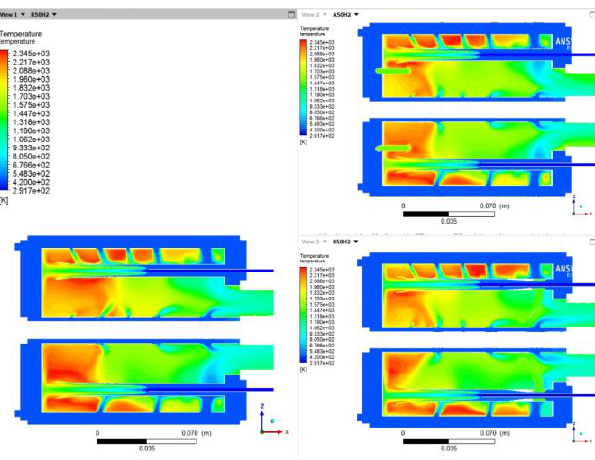
Fig. 10. Combustion static temperature field for 50% hydrogen mass percentage in fuel